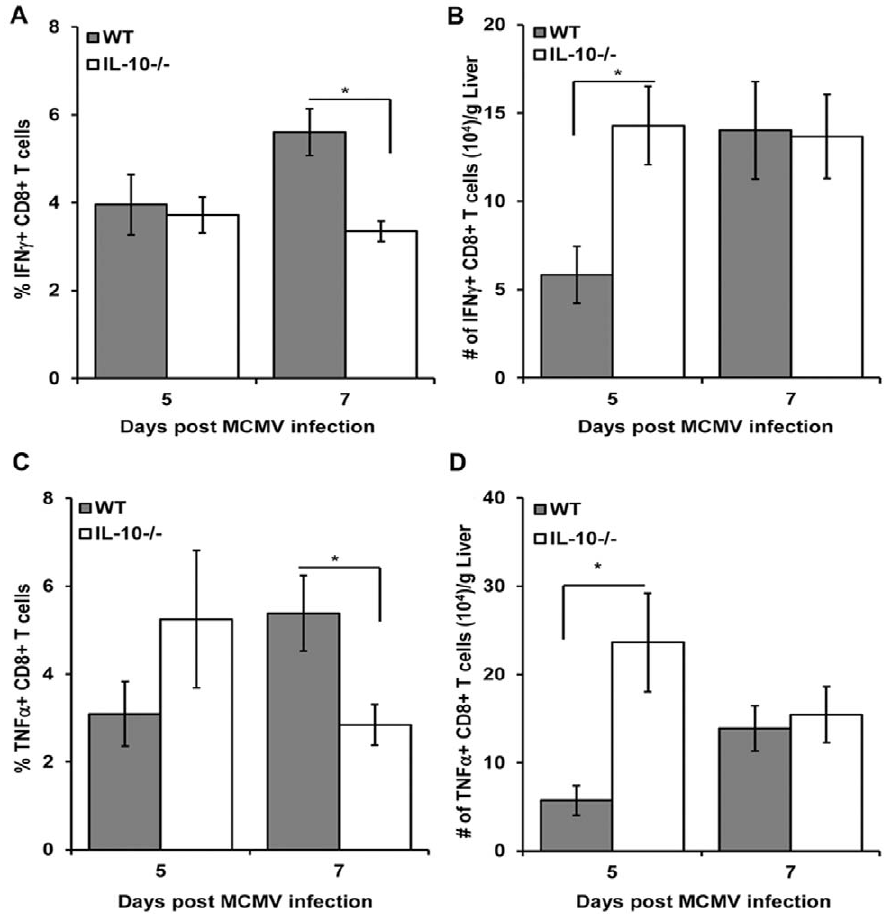
Figure 6. Effects of IL-10 deficiency on intracellular IFN- c and TNF- a expression in MCMV-primed CD8 + T cells. Liver leukocytes were prepared from C57BL/6J (WT) or IL-10 2 / 2 mice that were infected with MCMV for 5 and 7 days. As described in Materials and Methods, cells were stimulated with M45 viral peptide, stained for surface expression of CD8 a and TCR b , fixed, permeabilized, and stained for intracellular IFN- c or TNF- a . Results show the frequencies total numbers of CD8 + T cells expressing (A and B) IFN- c or (C and D) TNF- a . Data are combined from three independent experiments (n=9–10 mice per group for each time point tested) and show the means 6 SE. Asterisks denote statistically significant differences between WT and IL-10 2 / 2 groups, where p values are # 0.05 (Student’s T test).